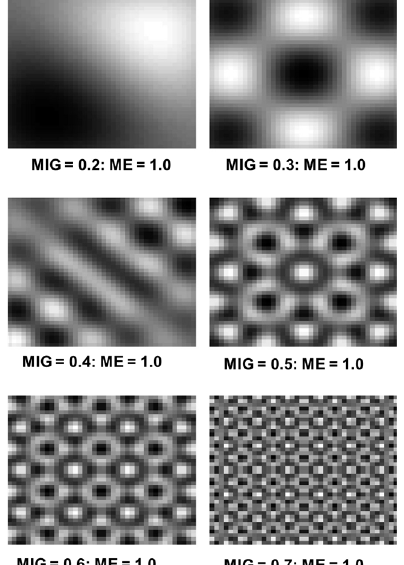
Figure 4. Comparison of changing MIG (0.2–0.7) with a constant ME. Reprinted from Ecological Indicators , 8/270–84, Raphaël Proulx, Lael Parrott, ‘Measures of structural complexity in digital images for monitoring the ecological signature of an old-growth forest ecosystem’, page 15, Copyright (2008), with permission from Elsevier.